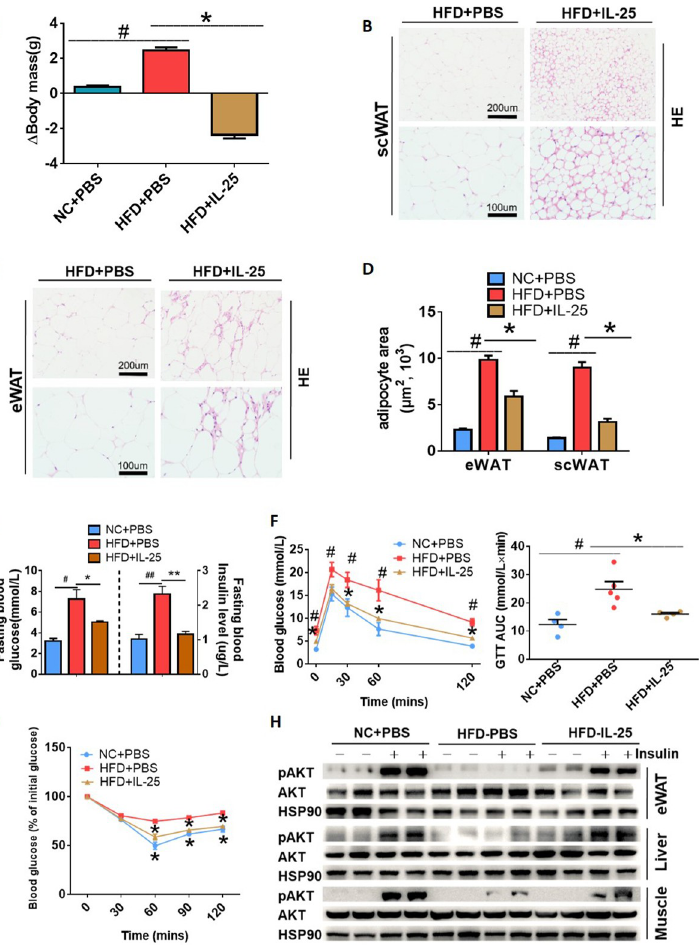
Fig 5. IL-25 improved the metabolic homeostasis of mice with DIO against obesity and insulin resistance. (A–H) C57/BL6J mice fed with an NCD or HFD for 12 weeks ( n = 5 per treatment) were injected with vehicle or IL-25 over 14 days. (A) The change in body mass in mice with different treatments. (B, C) Representative images of scWAT (B) and eWAT (C) stained with H&E. 200 × magnification (top), 400 × magnification (bottom). (D) The adipocyte area of scWAT or eWAT in HFD-induced obese mice injected with vehicle or IL-25 for 14 days. (E) The fasting blood glucose and insulin in HFD-induced obese mice injected with vehicle or IL-25 for 14 days. (F) GTT was conducted by intraperitoneal injection of glucose (2 g � kg − 1 ) and measurement of blood glucose concentration with a OneTouch Ultra Glucometer at designed time points in overnight-fasted mice. (G) ITT was done by IP injection of insulin (0.75 U � kg − 1 ) and measurement of blood glucose concentration by a OneTouch Ultra Glucometer at designed time points in 8 h–fasted mice. (H) Western blot analysis of the phosphorylation of AKT and total AKT in eWAT, liver, and muscle. The tissues were harvested within 10 minutes after an injection of insulin (0.5 U � kg − 1 ). # p < 0.05, compared with NCD group, � p < 0.05, compared with HFD group by two-sided unpaired t test. Data present as mean ± SEM. The data underlying this figure can be found in S1 Data. auc, area under the curve; DIO, diet-induced obesity; eWAT, epididymal WAT; GTT, glucose tolerance test; HE, hematoxylin and eosin; HFD, high-fat diet; IL, interleukin; IP, intraperitoneal; ITT, insulin tolerance test; NCD, normal chow diet; scWAT, subcutaneous WAT.